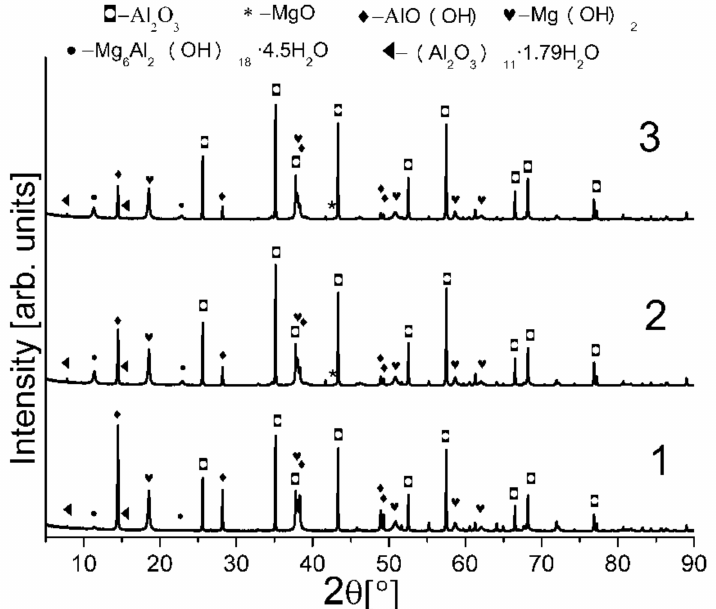
Figure 2. X-ray diffraction spectra of studied samples (1—reference sample; 2—sample with citric acid addition; and 3—sample with tartaric